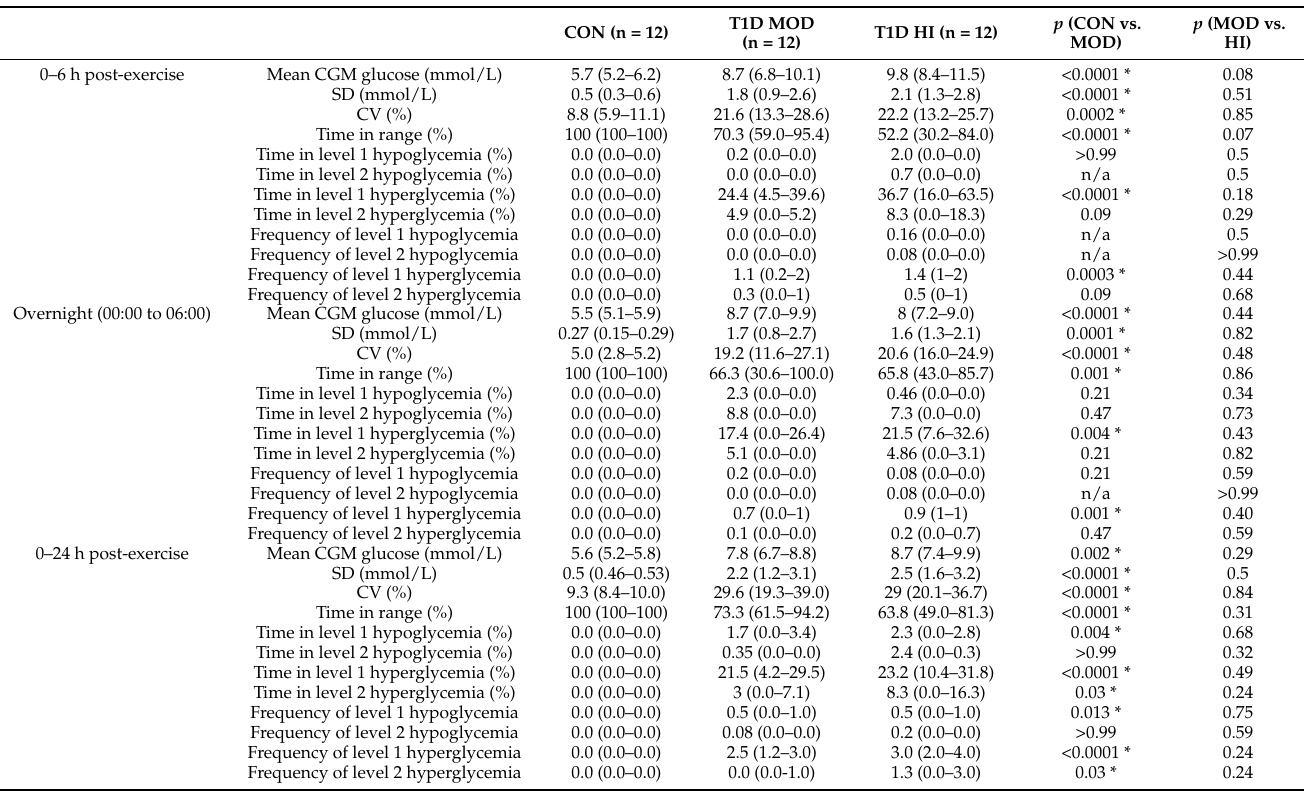
Table 2. Post-exercise glucose and glycemic variability in control and PWT1D measured by